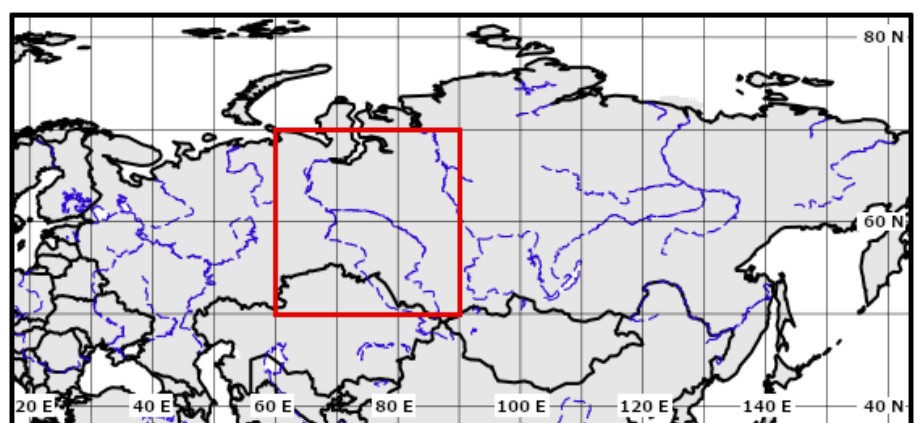
Figure 1. Geographical location of the study region (marked with a red box).